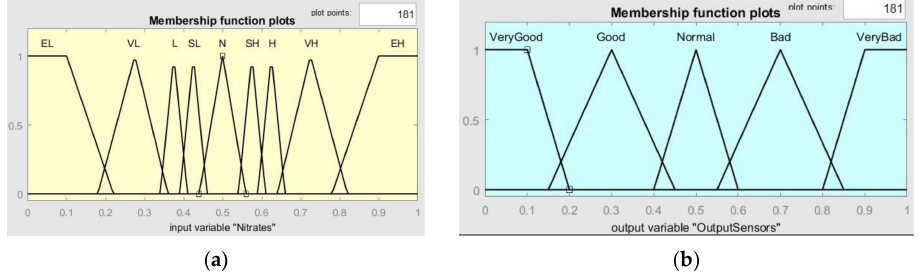
Figure 8. ( a ) Membership functions for each of the six sensors (shown for nitrates), where EL: extremely low, VL: very low, L: low, SL: slightly low, N: normal, SH: slightly high, H: high, VH: very high, EH: extremely high; ( b ) Output membership function for classifying the boxes according to sensor